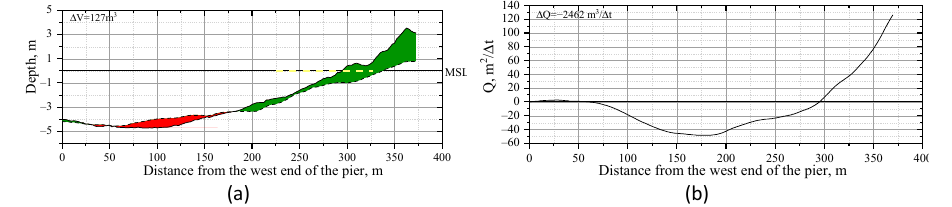
Figure 8. Cross-shore profile changes (green-sand accumulation, red-sand loss) ( a ) and sediment transport rate Q ( b ) over the period 2000 to 2016.